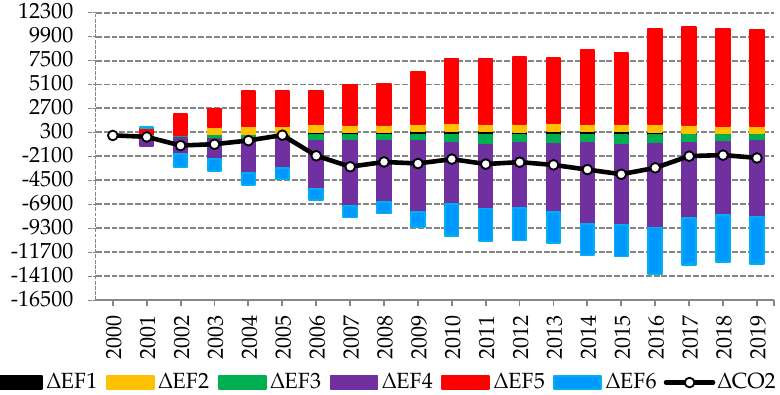
Figure 5. Graphical presentation of the decomposition of changes in CO 2 emissions from energy consumption in Polish agriculture in 2000 – 2019 ( aggregate effects ).